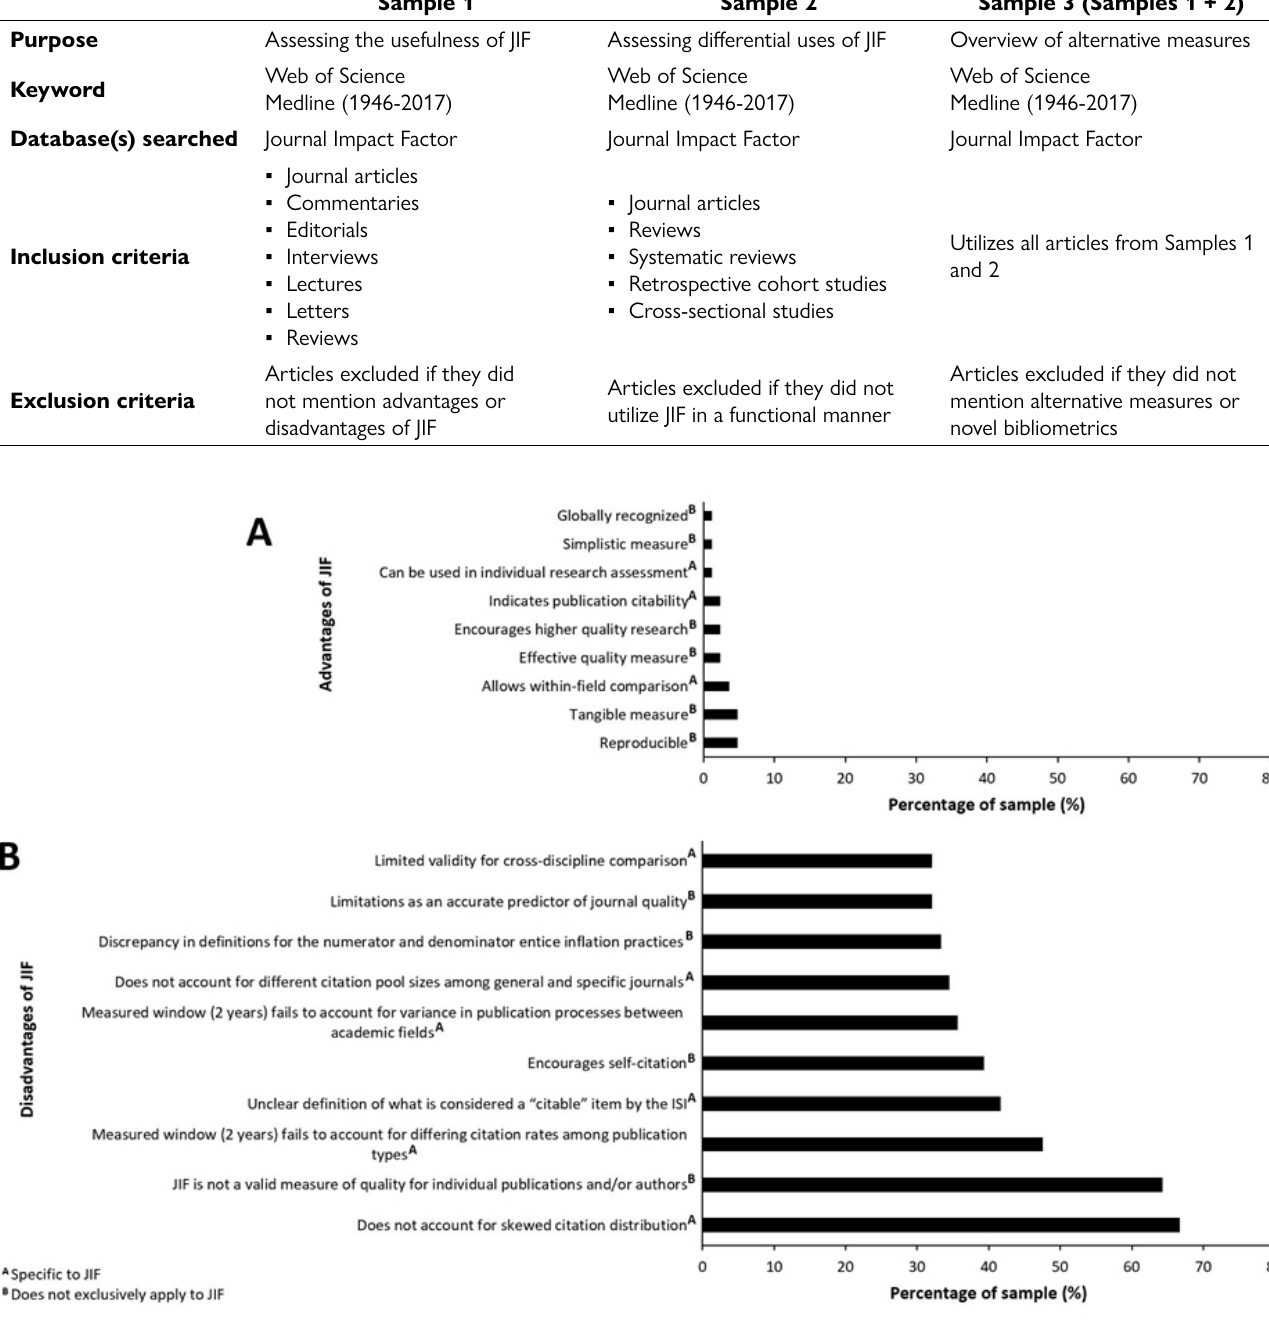
Figure 1. Percentage of sample reporting specific advantages and disadvantages of JIF (n = 84). (A) Recorded advantages of JIF. (B) Recorded disadvantages of JIF. Subscript letters A and B show which advantages/disadvantages are specific to and do not exclusively apply to JIF,